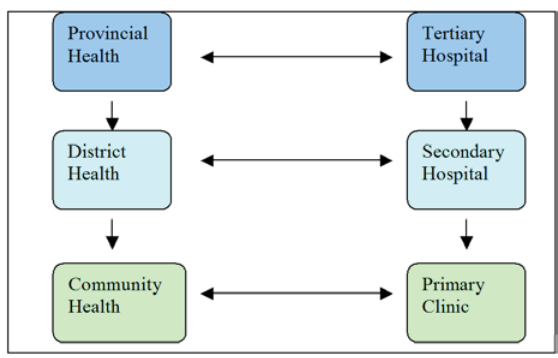
Figure 1. Levels of healthcare in South